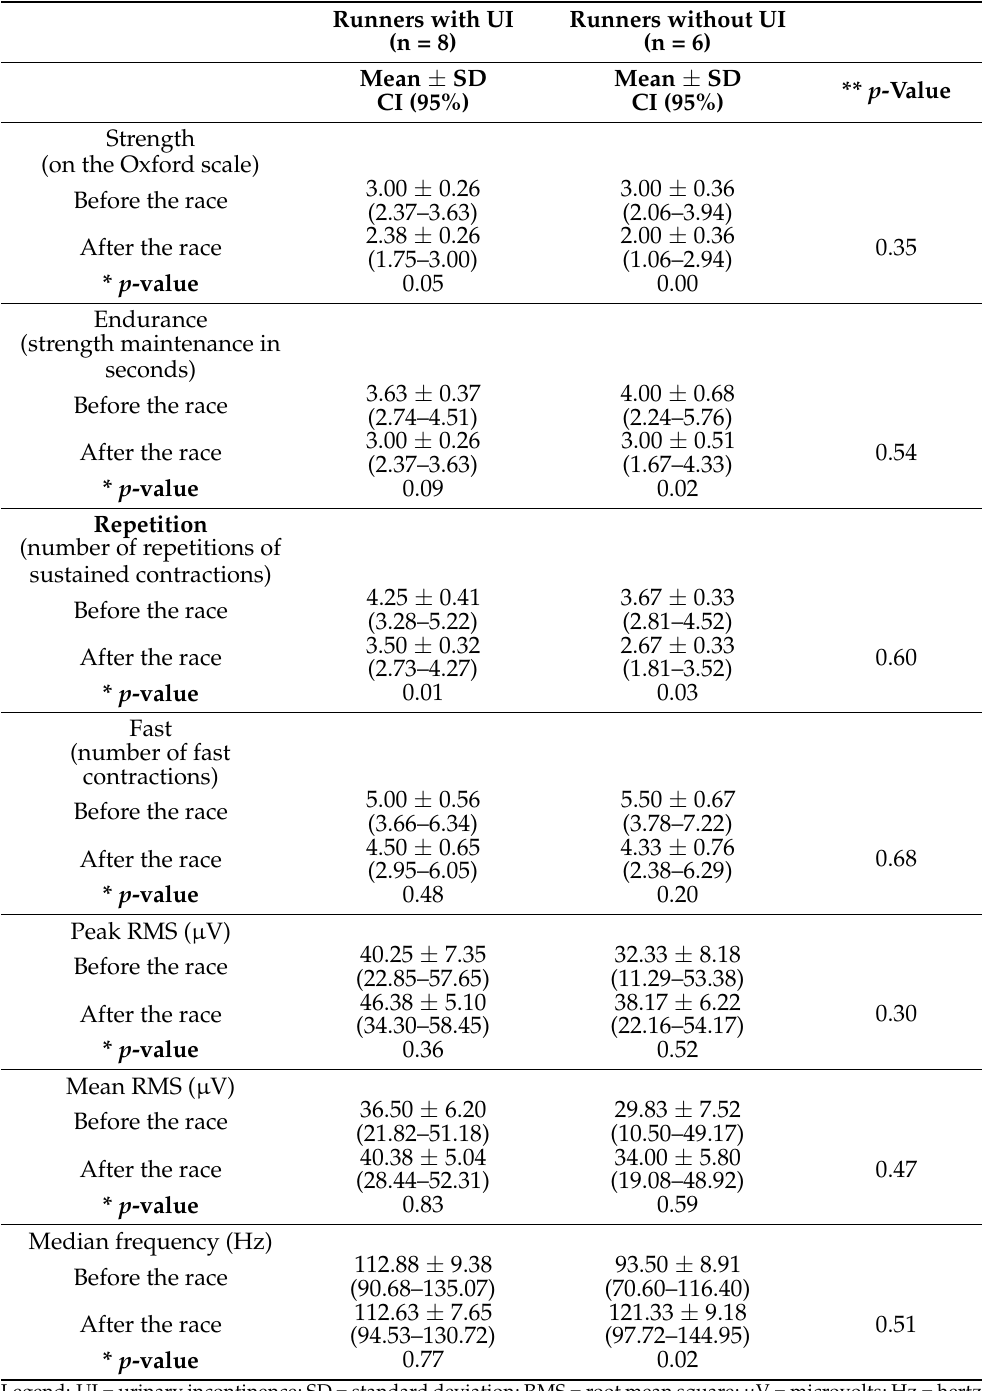
Table 3. Comparison of mean function (PERFECT method) and PFM electromyographic activity within and between groups of female half-marathon runners with and without UI. Pernambuco, Brazil,